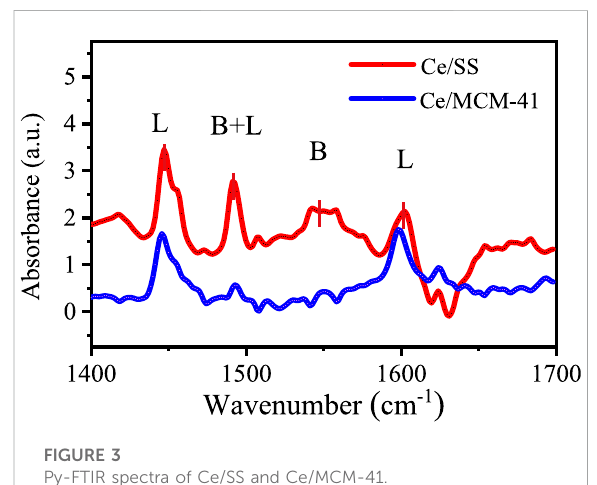
FIGURE 3 Py-FTIR spectra of Ce/SS and Ce/MCM-41.